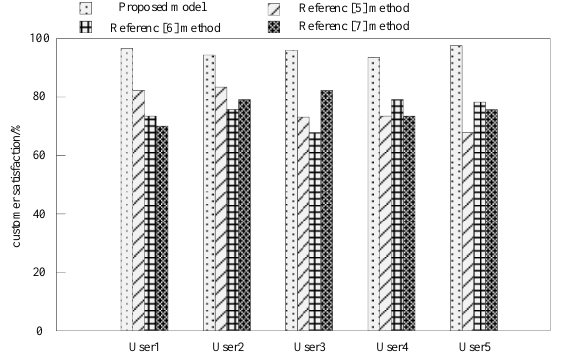
Figure 5. Results of user satisfaction